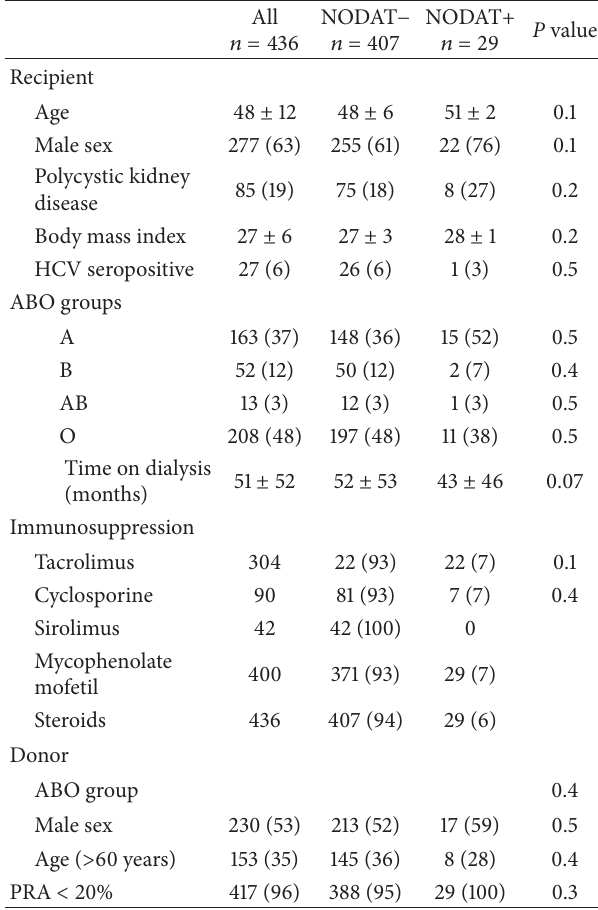
Table 1: Baseline characteristics of the study